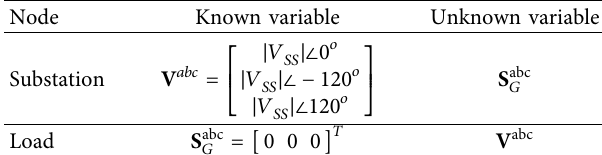
Table 1: Known and unknown variables in DSLF